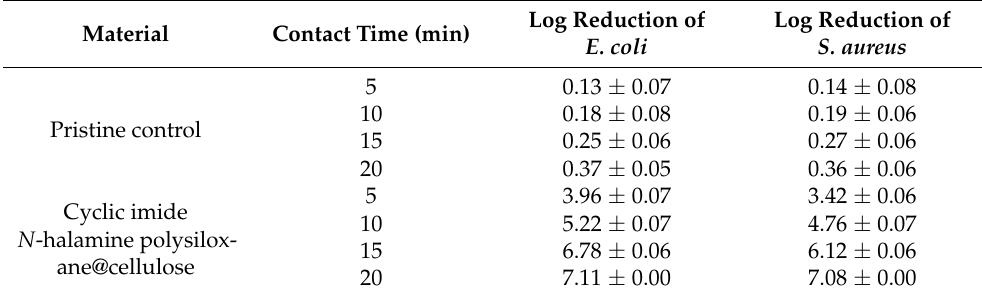
Table 1. Antibacterial function of cyclic imide N -halamine polysiloxane@cellulose and pristine